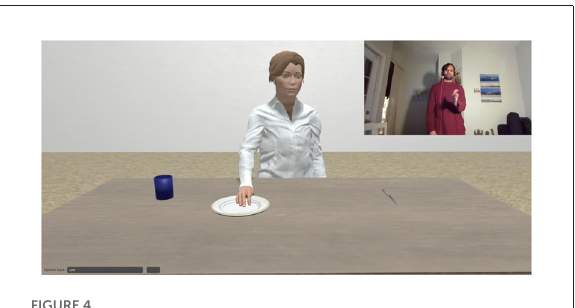
FIGURE4 Diana interacting with a human in the “Kitchen World”